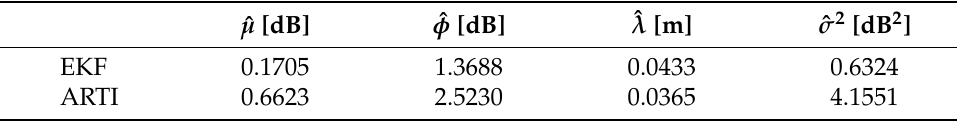
Table 4. RMSE of parameter